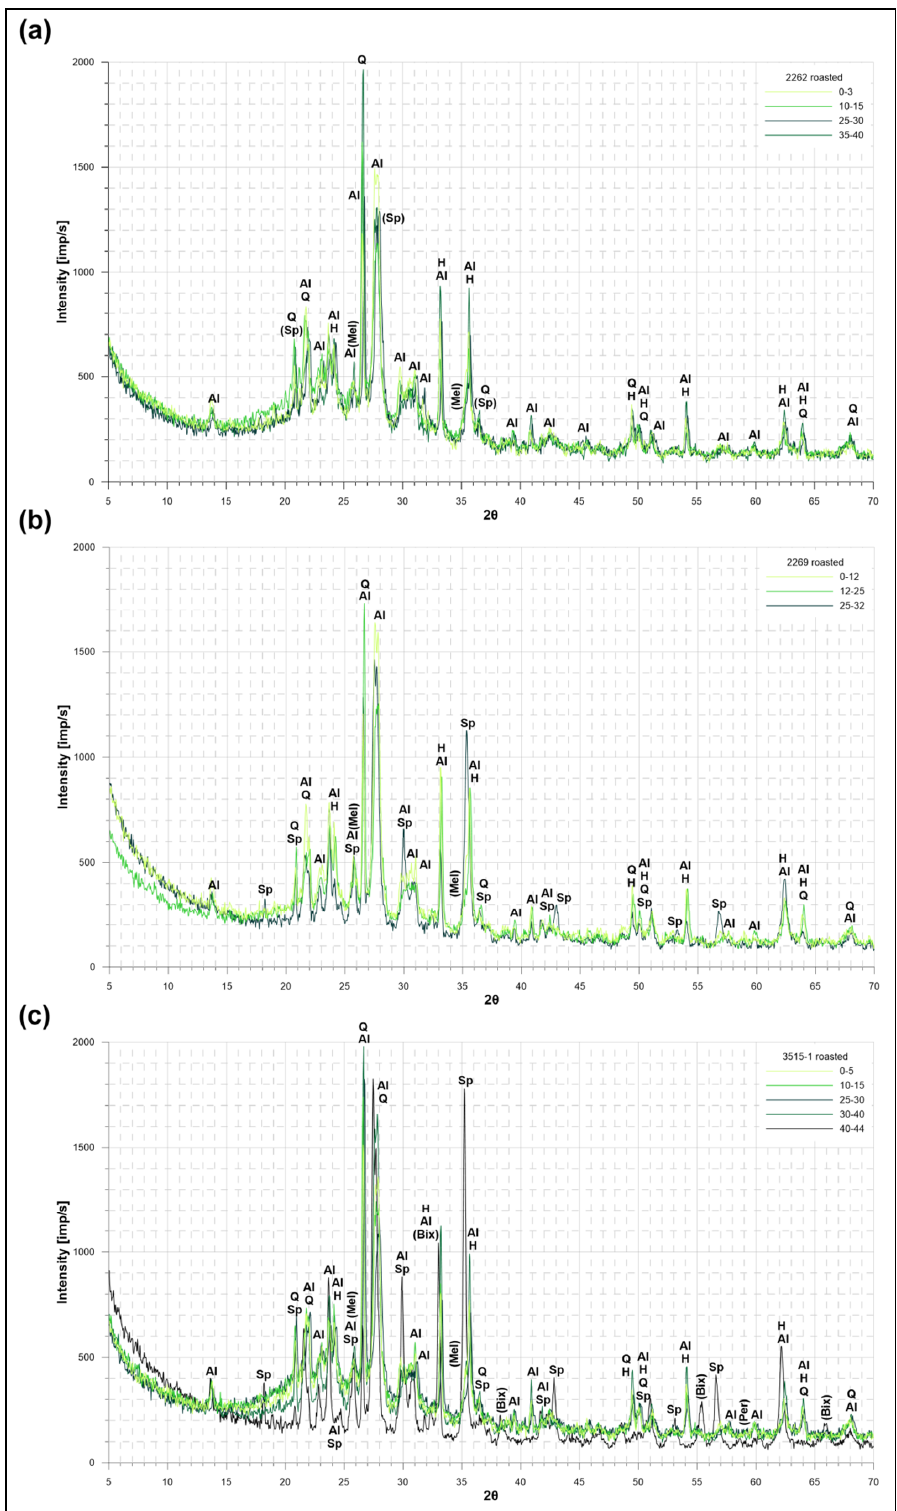
Figure 8. The XRD diffraction patterns of heated samples from the CCFZ, IOM claim area ( a – c ): Q—quartz and crystobalite, Al—albite, H—protohematite and hematite, Sp—spinels, Mel—melilite, Bix—bixbyite, Per—periclase. Increase in crystallinity (=background decrease) observed with burial depth.